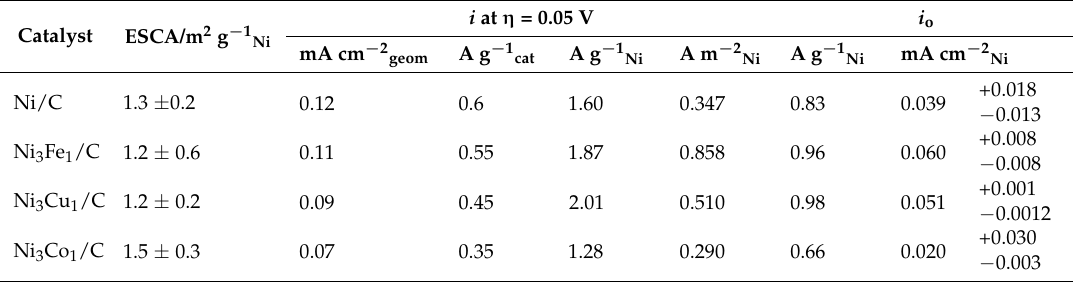
Table 1. Comparison of surface area values and the HOR electrocatalytic properties for different catalysts.